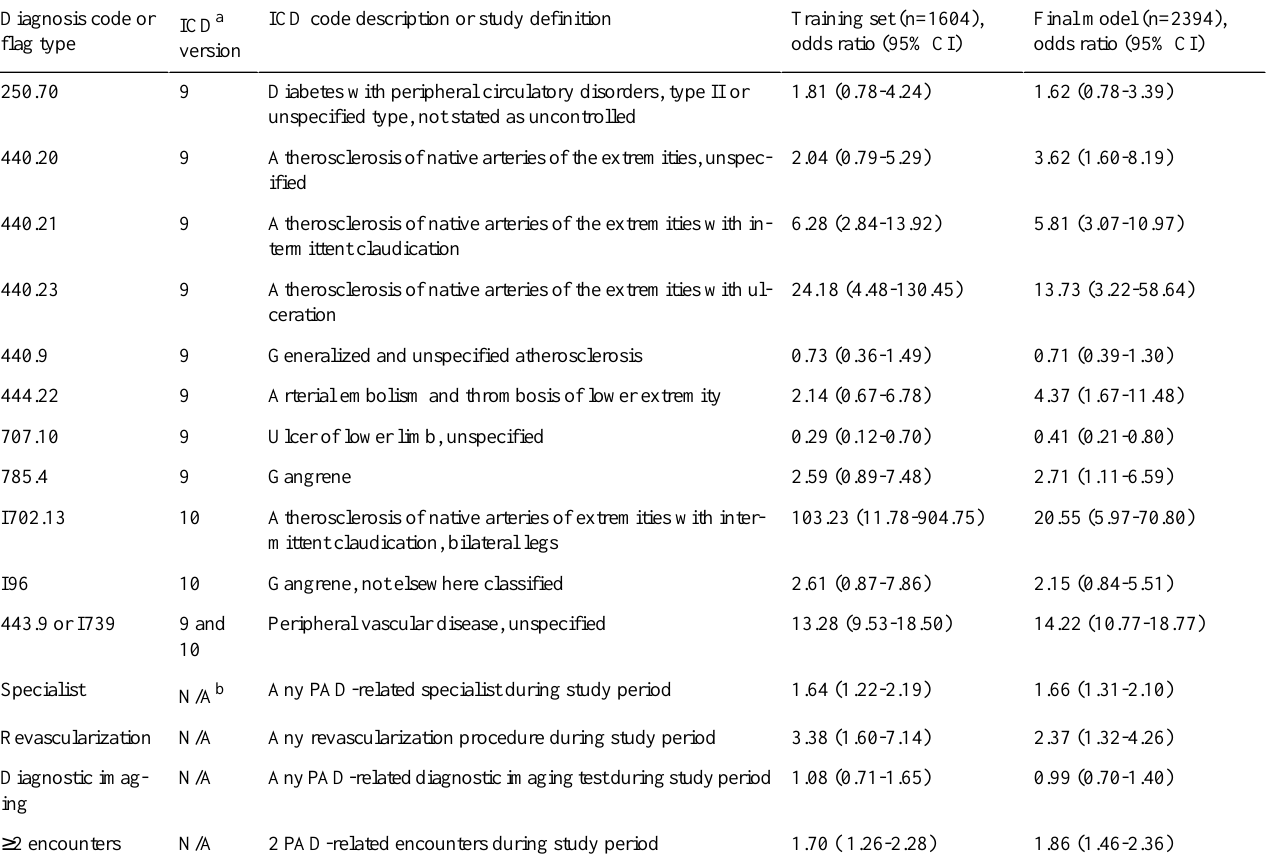
Table 2. Odds ratio estimates and 95% confidence intervals from the training set and the final model using the variables selected in the least absolute shrinkage and selection operator (LASSO) model.